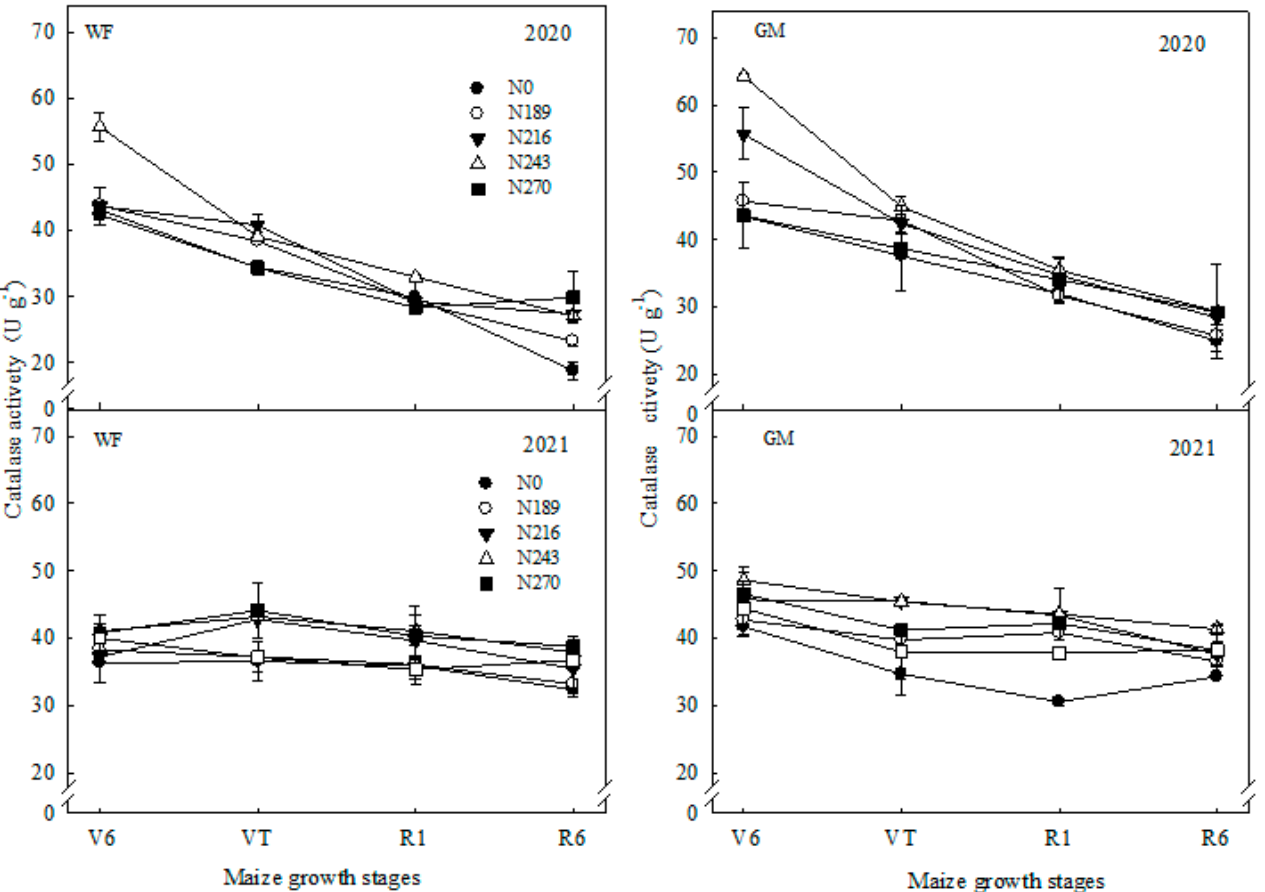
Figure 2. The soil catalase activity response to N application under WF and GM treatments in the North China Plain. V6, spring maize jointing stage; VT, spring maize tasseling stage; R1, spring maize filling stage; R6, spring maize maturity stage.